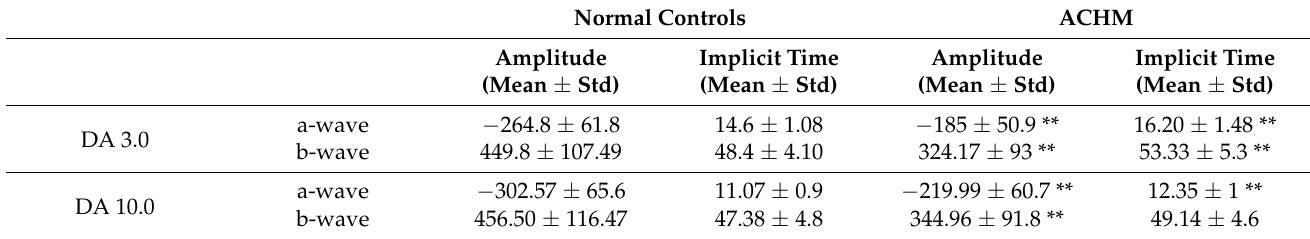
Table 1. Mean and standard deviation of amplitudes and implicit times of a- and b-waves (DA 3.0 and DA 10.0). Asterisks (**) correspond to a p -value < 0.001.